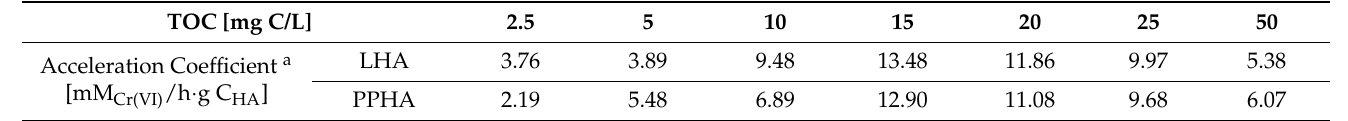
Table 2. The calculated acceleration coefficients based on the rates of Cr(VI) reduction by LHA and PPHA samples at corresponding different TOC